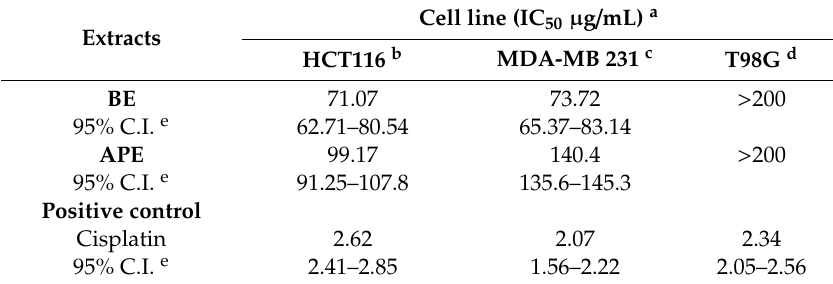
Table 4. Cytotoxicity of the ethanolic extract from bulb (BE) and aerial parts (APE) of Allium subhirsutum , expressed as IC 50 values on human tumor cell